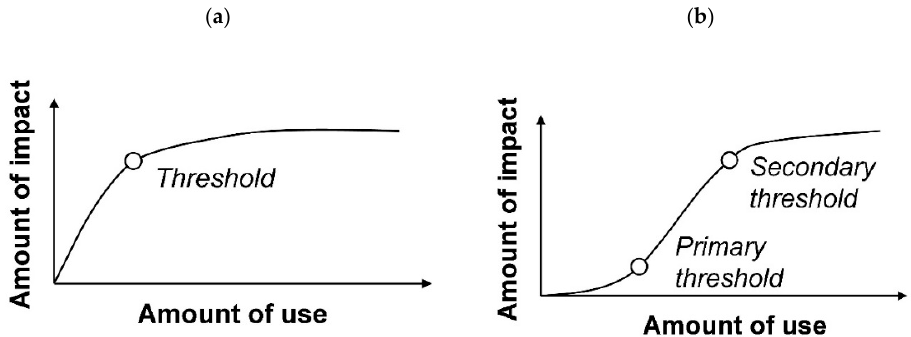
Figure 2. The ( a ) curvilinear (modified after [33]) or ( b ) logistic (modified after [35]) relationship between amount of use (usage intensity) and amount (magnitude) of impact.